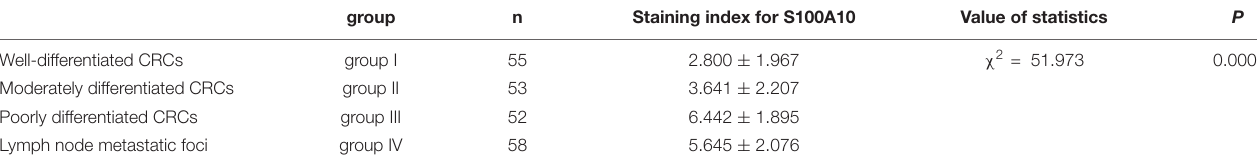
TABLE 1 | Differences of S100A10 staining index in different group of human CRCs. group n Staining index for S100A10